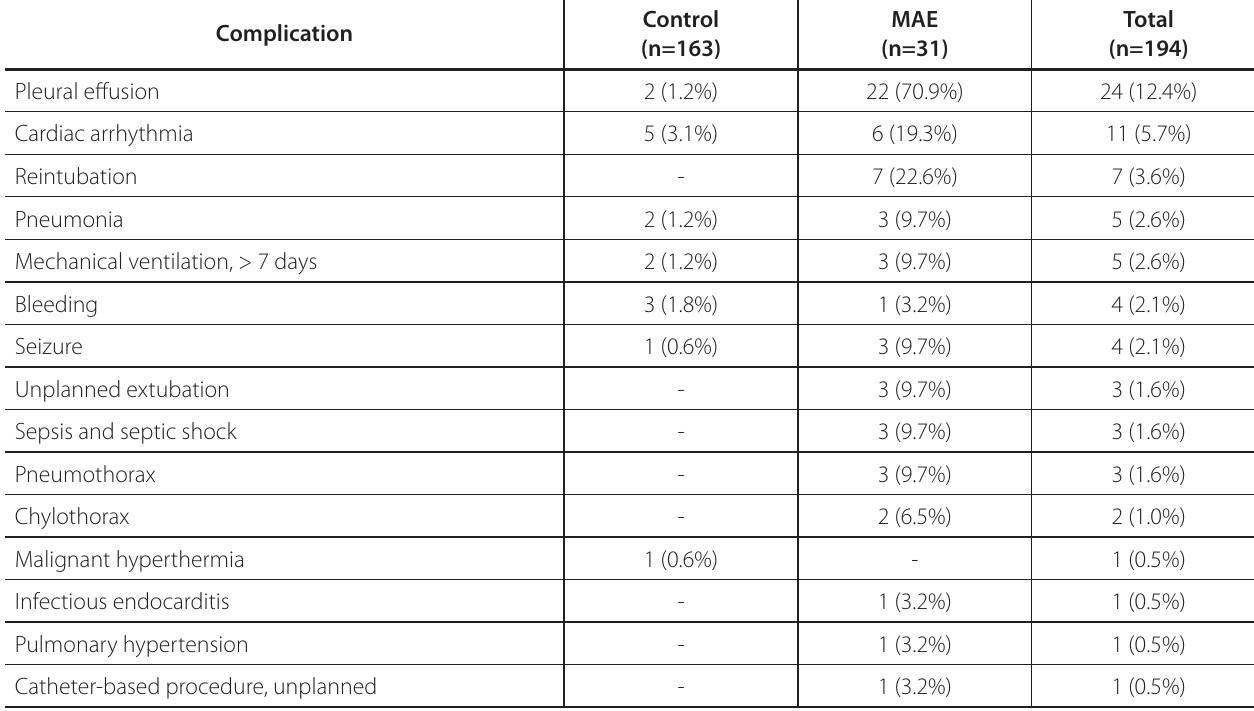
Table 3 . Postoperative complications, according to the occurrence of a major adverse event (MAE) within 48 hours after surgery.